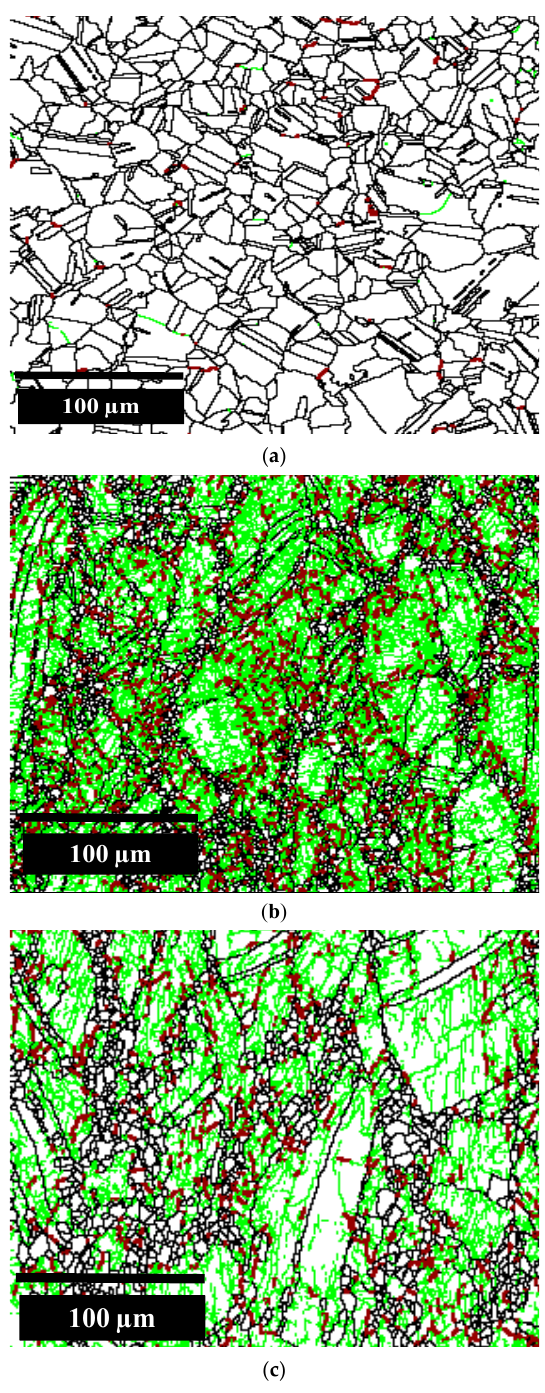
Figure 6. Results of EBSD grain boundaries (green and red < 15 ◦ ; black > 15 ◦ ): ( a ) specimen without deformation; ( b ) Specimen A; ( c ) Specimen